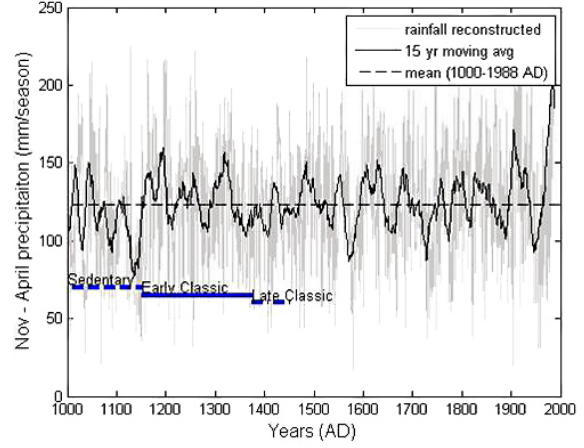
Fig. 12. Tree-ring reconstruction of winter precipitation (mm/season) in southwestern Arizona, United States from AD1000 to 2000. Also shown are the three major eras of the Hohokam civi- lization and the mean of the time series over the entire period. Com- piled from http://www.ncdc.noaa.gov/paleo/pubs/ni2002/az6.html; see also Ni et al.